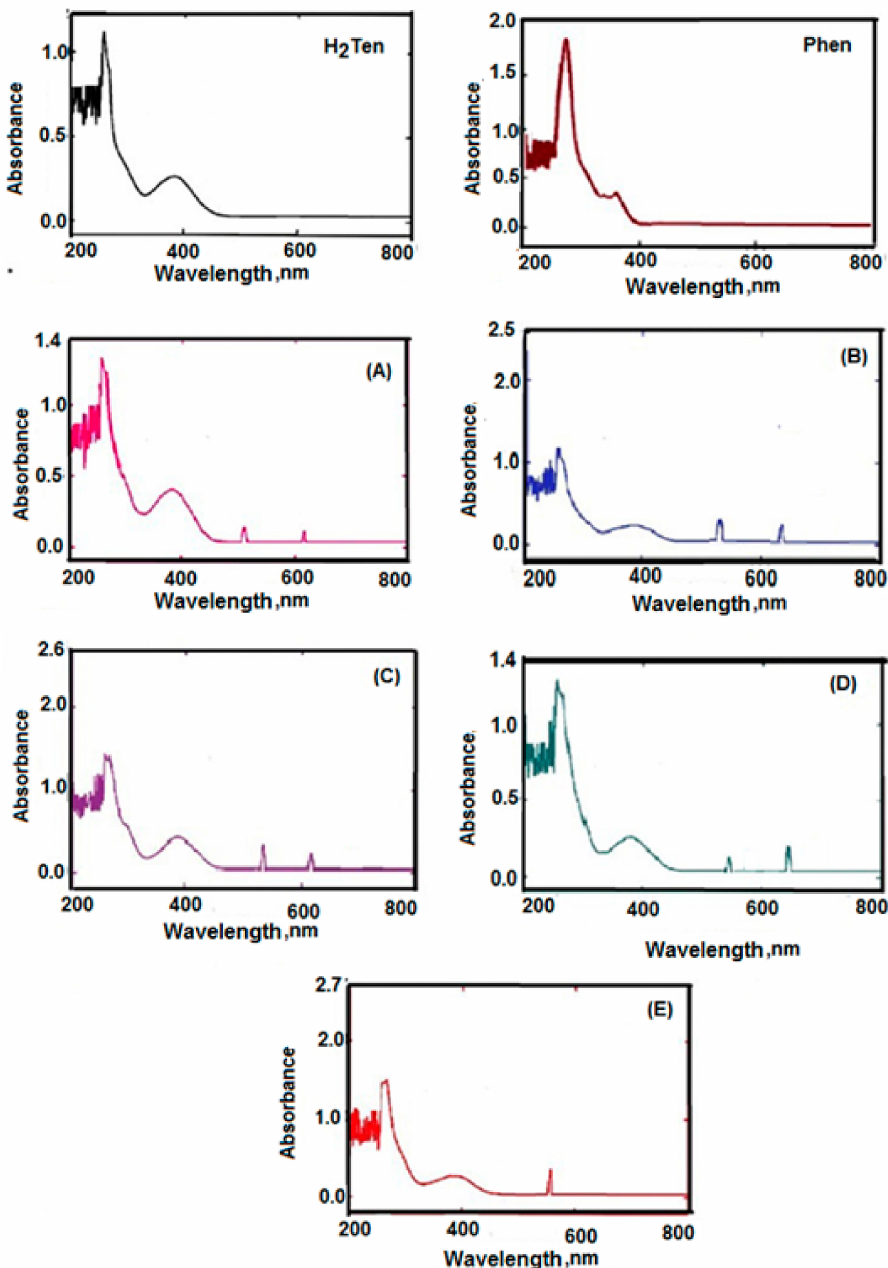
Figure 1. Electronic absorption spectrum for H 2 Ten, Phen and their metal complexes. Where: H 2 Ten: Tenoxicam; Phen: 1,10-Phenanthroline; ( A ) Manganese complex; ( B ) Cobalt complex; ( C ) Nickel complex; ( D ) Cupper complex; ( E ) Zink